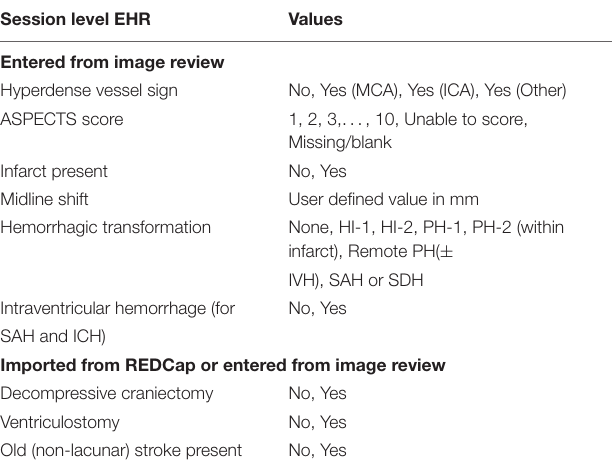
TABLE 2 | SNIPR can pull stroke’s clinical data from REDCap and manage these data at session level.